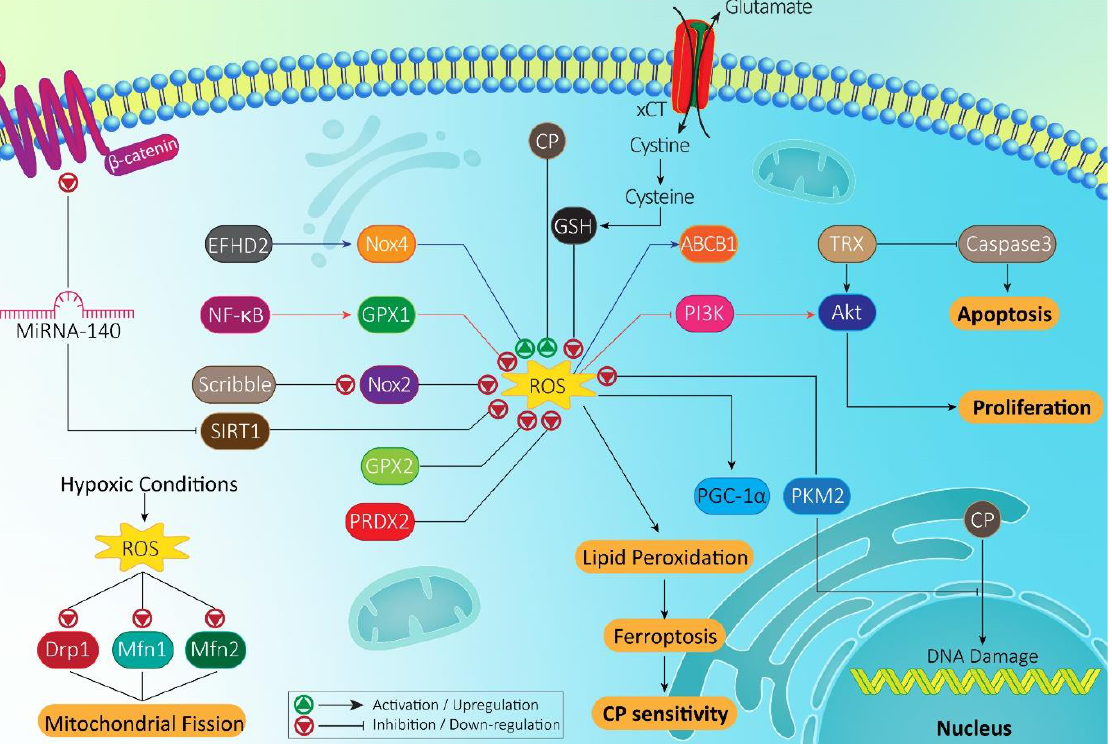
Figure 2. Molecular pathways regulating ROS in CP resistance. Mainly, ROS inhibition results in CP resistance, and upstream mediators including Nox2, GPX2, and SIRT1 can reduce ROS levels in mediating CP resistance. Furthermore, hypoxia affects ROS levels and mitochondrial function in CP resistance.